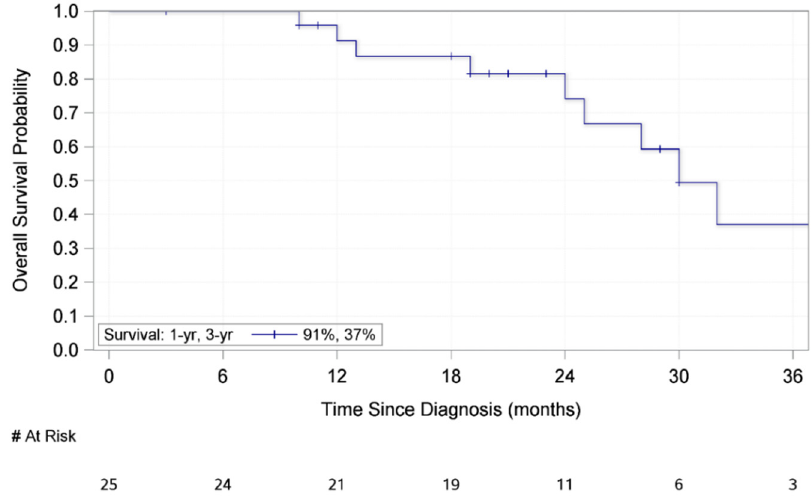
Figure 2. Kaplan–Meier Curve for Overall Survival of 25 Patients who Underwent Surgical Resection of a Subungual